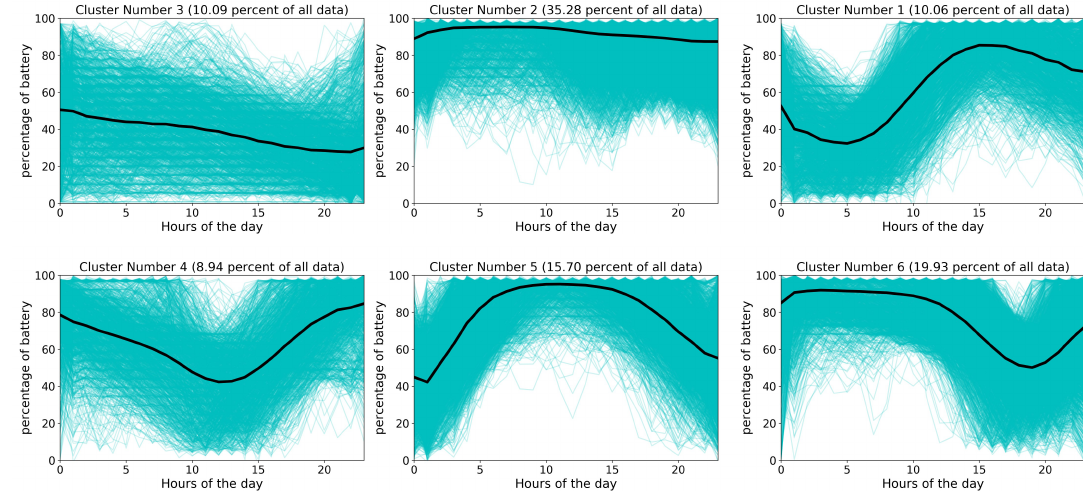
Figure 4. Result of the k -means clustering. These plots present the average percentage of battery drain based on the hours of a day. Cyan is used to show time series in the same cluster, and black curves show the center of each cluster.